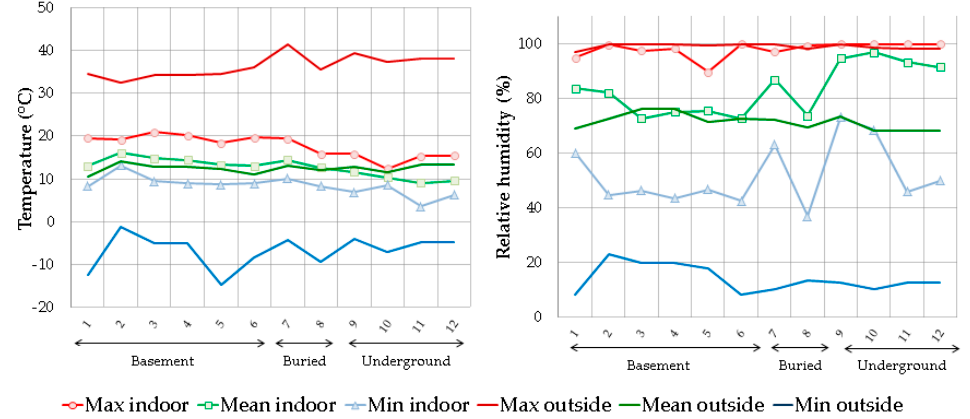
Figure 5. Annual temperature and relative humidity differences between the inside and outside of the